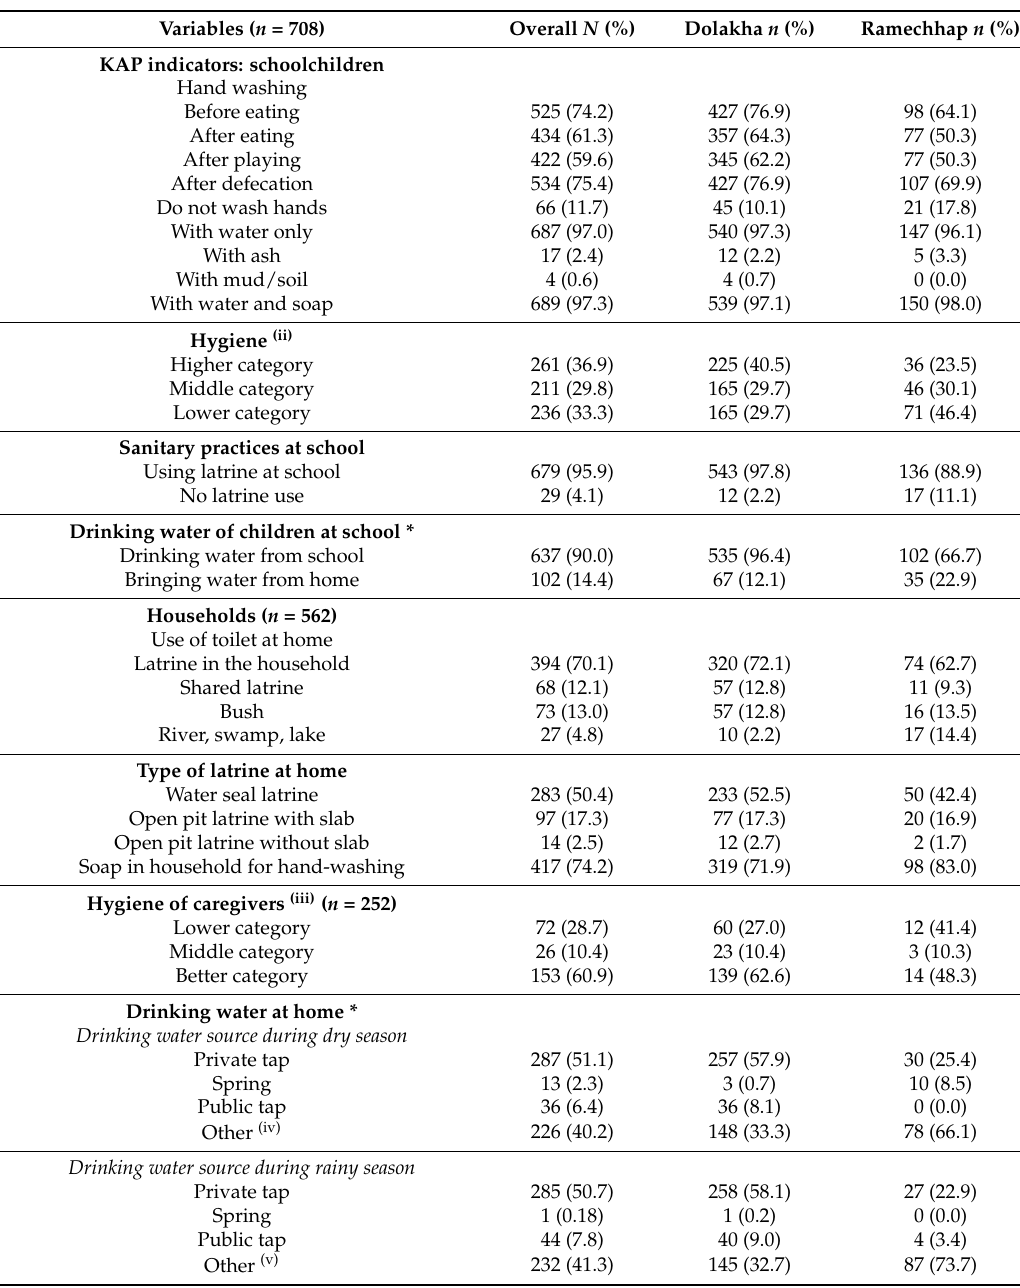
Table 4. Questionnaire findings on KAP (i) on WASH among schoolchildren and caregivers in Dolakha and Ramechhap districts, Nepal, March–May